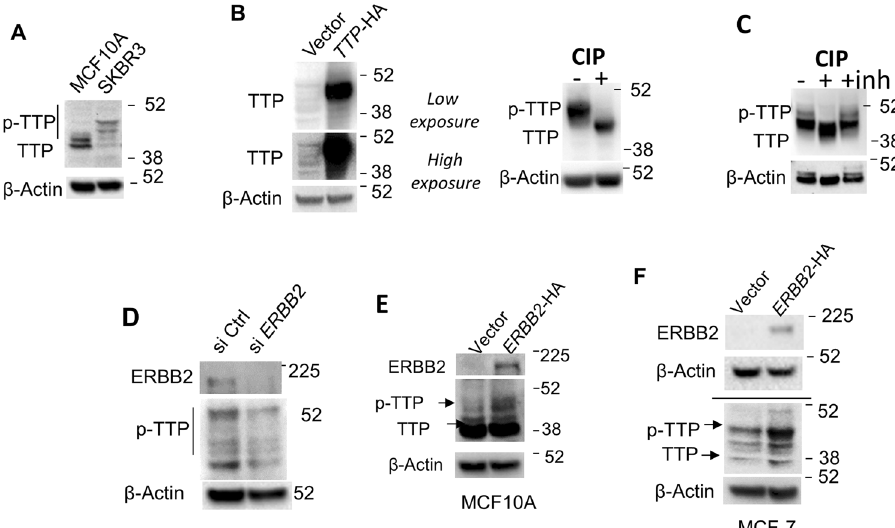
Fig. 4 ERBB2 signaling-mediated phosphorylation of ZFP36/TTP. A immunoblot analysis for ZFP36/TTP phosphorylated protein abundance in MCF10A and SKBR3 using speci fi c primers to ZFP36/TTP and β -Actin protein as a loading control. B SKBR3 cells were transfected with an empty vector or ZFP36/TTP expression vector. Left panel: proteins were extracted, and immunoblotting was performed using a ZFP36/TTP antibody. Right panel: protein lysates were fi rst treated with the phosphatase, CIP, or CIP phosStop C before immunoblotting with anti-ZFP36/ TTP. The WB shows both phosphorylated and unphosphorylated bands. WB was performed with low exposure to avoid high background and overexposed signal of the transfected TTP (lower panel). D) SKBR3 cells were transfected with 200 nM ERBB2 siRNA or control siRNA for overnight, and ERBB2 and ZFP36/TTP protein abundance were assessed by immunoblotting. A representative blot from at least two experiments is shown. Immunoblot analysis of ERBB2 and ZFP36/TTP protein phosphorylation abundance in MCF10A ( E ) or MCF-7 ( F